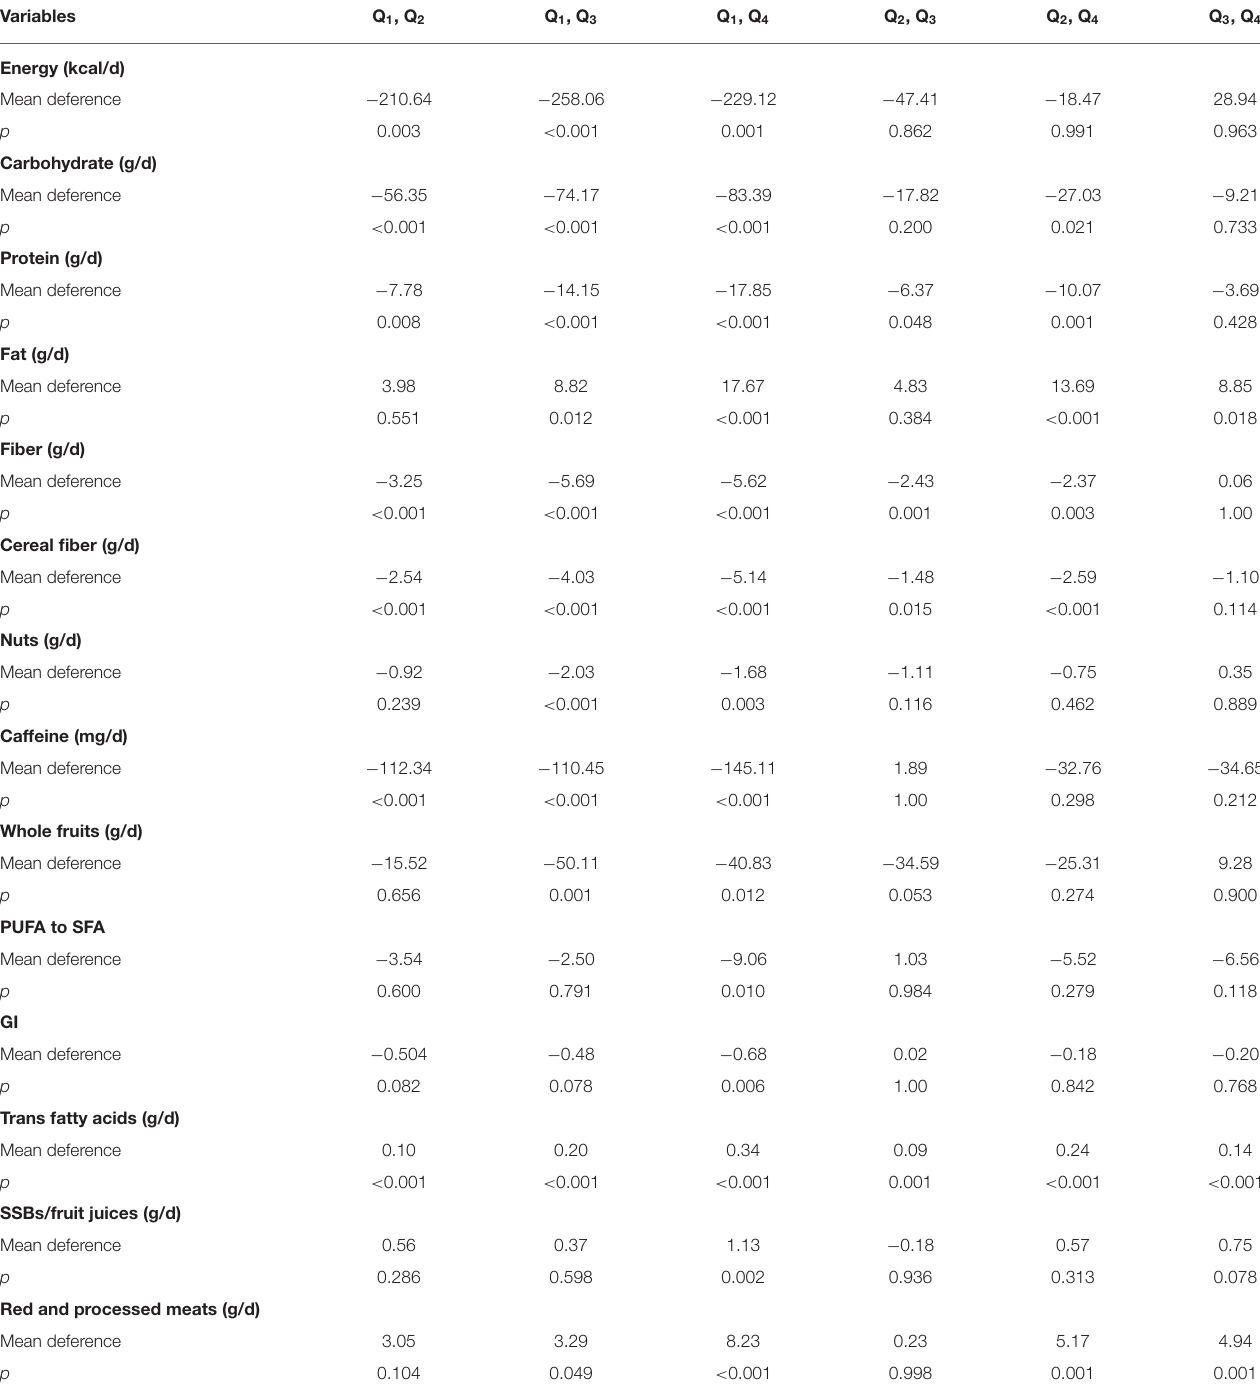
TABLE 3 | Pairwise comparison of the dietary intakes across each quartile categories of DRRDS * . Variables Q 1 , Q 2 Energy (kcal/d) Mean deference